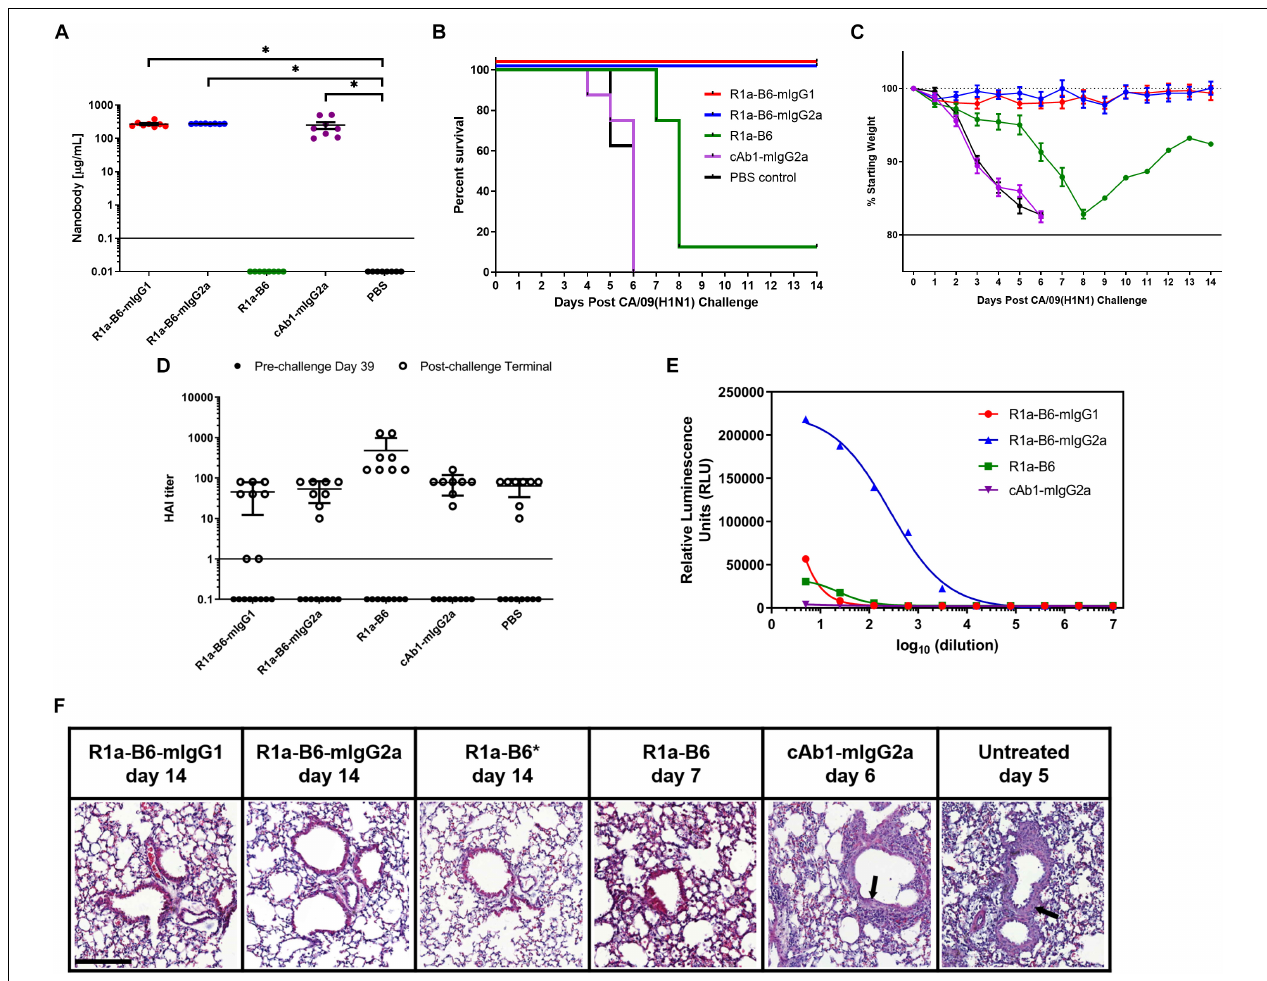
FIGURE 4 | Prophylactic efficacy of AAV expressed nanobodies in a mouse challenge model of pandemic H1N1 CA/09. (A) Total nanobody-Fc in serum was measured by ELISA in samples taken 39 days after IM injection of AAV vectors pre-challenge with CA/09. Comparisons are shown in brackets ( *p < 0.05). BALB/c mice were then infected intranasally with 21 MLD 50 (mouse lethal dose) of A/California/07/2009(H1N1)pdm09 42 days post-AAV IM injection. Survival (B) and weight loss (C) were monitored for 14 days. (D) Naturally induced immune response in mice pre- and post-CA/09 challenge was assessed via Hemagglutination Inhibition (HAI) titers 39 days post-AAV administration and 3 days pre-challenge ( • ), and from post-challenge terminals bleeds ( ◦ ). HAI titers are expressed as the highest dilution of serum that inhibited hemagglutination completely. Points below the solid line represent no HAI activity. For panels (A–D) , each point represents an individual mouse. Mean and standard error of eight recipient mice per treatment is shown in panels (A) and (C,D) . (E) Binding and activation of mouse Fc γ RIV effector cells in mice given nanobody-Fc fusions delivered by AAV. Terminal mouse sera were tested for ADCC activity via activation of mFc γ RIV from representative mice after IM injection of 1.0 × 10 11 vg AAV-R1a-B6-mIgG1, AAV-R1a-B6-mIgG2a, AAV-R1a-B6, and AAV-cAb1-mIgG2a. Mice were culled 14 days post-challenge for R1a-B6-mIgG1, R1a-B6-mIgG2a, and R1a-B6, and 6 days post-challenge for cAb1-mIgG2a. Activity is shown in relative luminescence units (RLU) against dilution of mouse sera containing nanobody Fc fusions expressed in vivo . Each point is shown as the mean and standard error of three replicates. (F) Representative histological lung sections from mice that received AAV encoding R1a-B6-mIgG1, R1a-B6-mIgG2a, R1a-B6, cAb1-mIgG2a, and PBS (untreated) post-infection with CA/09. Lungs were harvested from mice as they exited the study at the days indicated and stained with Hematoxylin and Eosin (H&E). Arrows represent thickening of the alveolar walls. *Represents Mouse 3 ( Supplementary Figure 2 and Supplementary Table 2 ), the only mouse that survived the CA/09 challenge from the R1a-B6 group. Scale bar = 100 µ